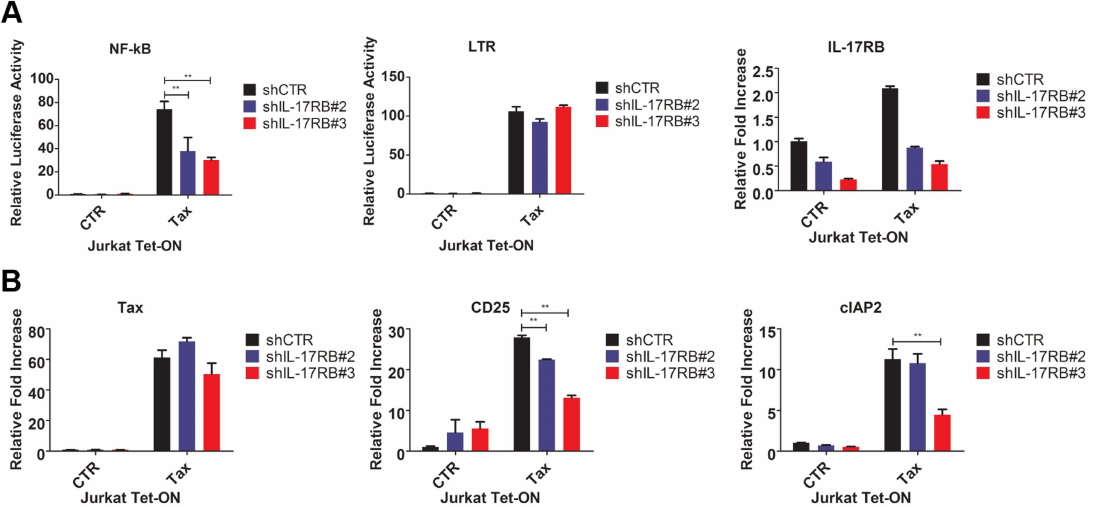
Figure 3. Tax requires IL-17RB for NF- k B activation in T cells. ( A ) NF- k B and HTLV-1 LTR luciferase assays and qRT-PCR of IL-17RB mRNA in Jurkat Tax Tet-On cells transduced with lentiviruses expressing control or IL-17RB shRNA. Cells were also transiently transfected with NF- k B and HTLV- 1 LTR luciferase reporters and treated with Dox (1 m g/ml) for 24 h. ( B ) qRT-PCR of Tax, CD25 and cIAP2 mRNAs in Jurkat Tax Tet-On cells from panel